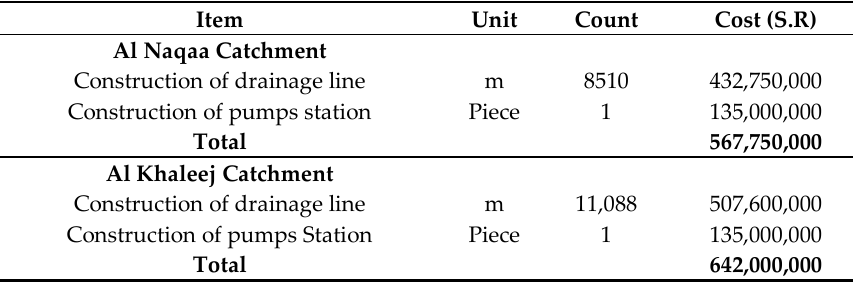
Table A1. Total cost for micro- tunneling drainage system in Al Naqaa and Al Khaleej catchments. Item Unit Count Cost (S.R) Al Naqaa Catchment Construction of drainage line m 8510 432,750,000 Construction of pumps station Piece 1 Total Al Khaleej Catchment Construction of drainage